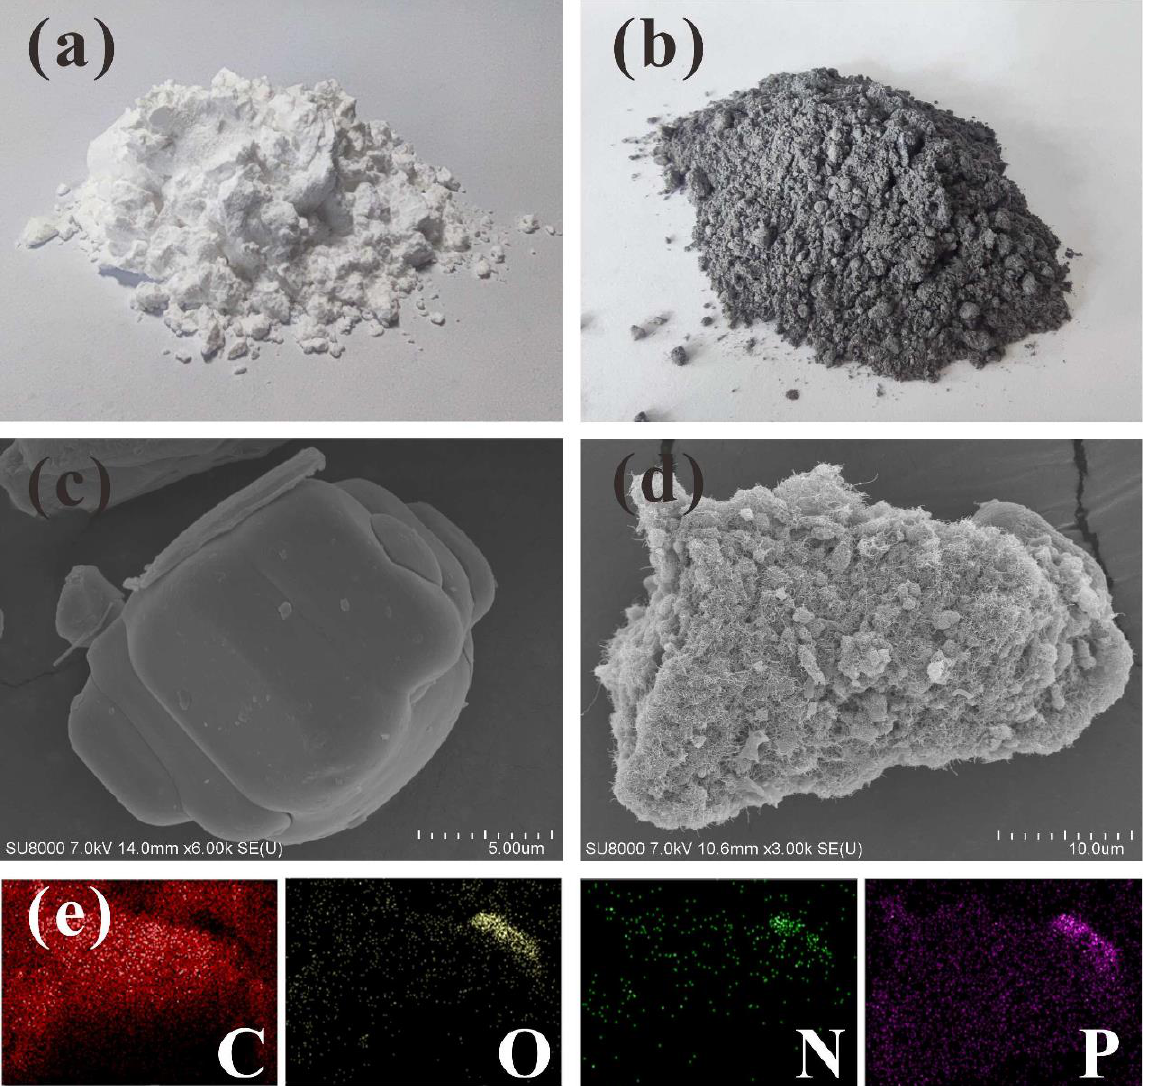
Figure 2. The digital and SEM images of APP and CTAPP: ( a ) macro view digital image of APP; ( b ) macro view digital image of CTAPP; ( c ) microscopic SEM image of APP; ( d ) microscopic SEM image of CTAPP; ( e ) EDS-mapping spectrum of the CTAPP.